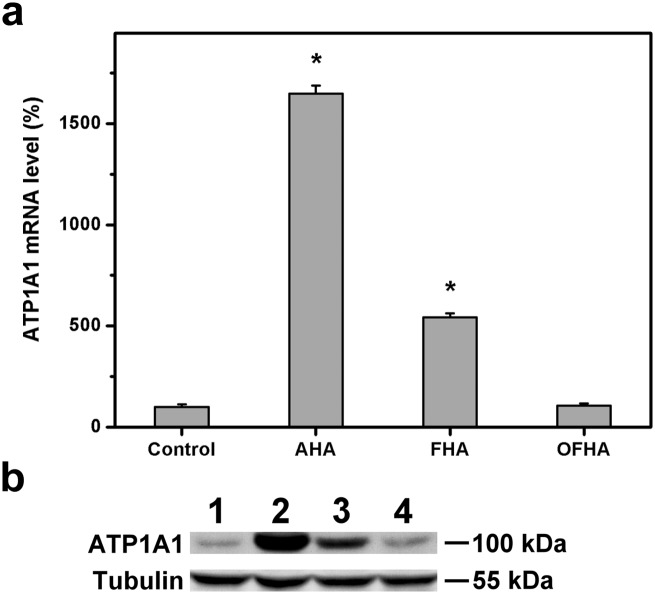
(a) Gene expression level of ATP1A1 in rabbit CECs after 8 h of direct contact with various HA carriers, measured by real-time reverse transcription polymerase chain reaction. Normalization was done by using GAPDH. Data in the experimental groups are percentages relative to that of control groups (cells cultured in the absence of HA materials). An asterisk indicates statistically significant differences (*P < 0.05; n = 4) as compared to the control groups. (b) Western blot analysis of ATP1A1 expression in the rabbit CECs after 8 h of direct contact with HA carriers. Lane 1: control (without HA materials), Lane 2: AHA, Lane 3: FHA, and Lane 4: OFHA groups.